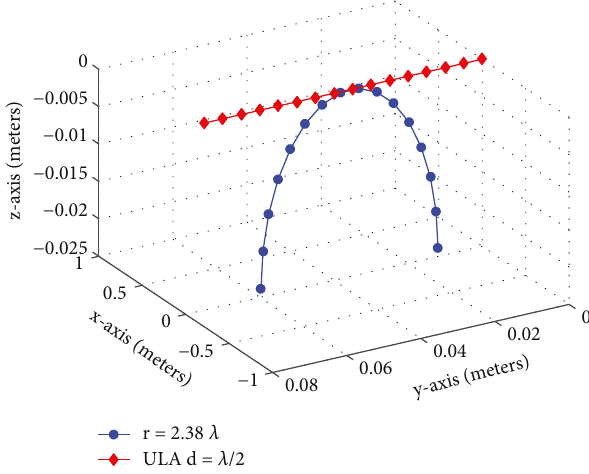
Figure 10: Element positions for the ULA in fl at and wrist-wrapped